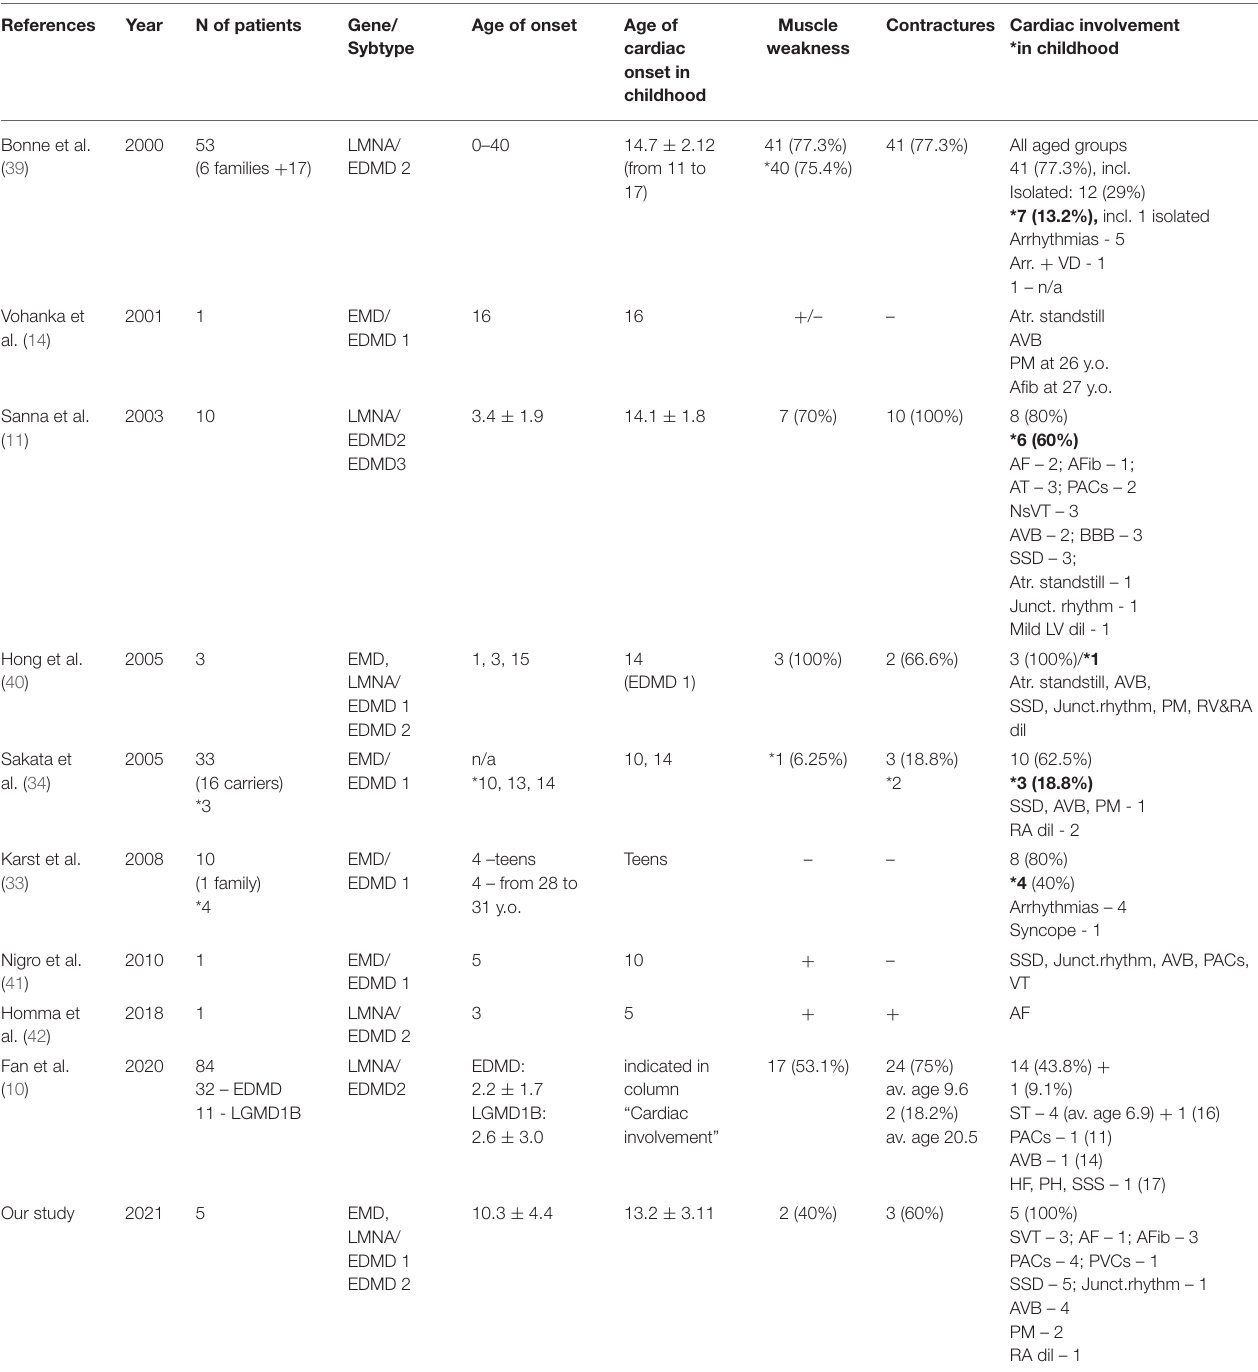
TABLE 2 | Literature review on heart rhythm disturbances in EDMD in